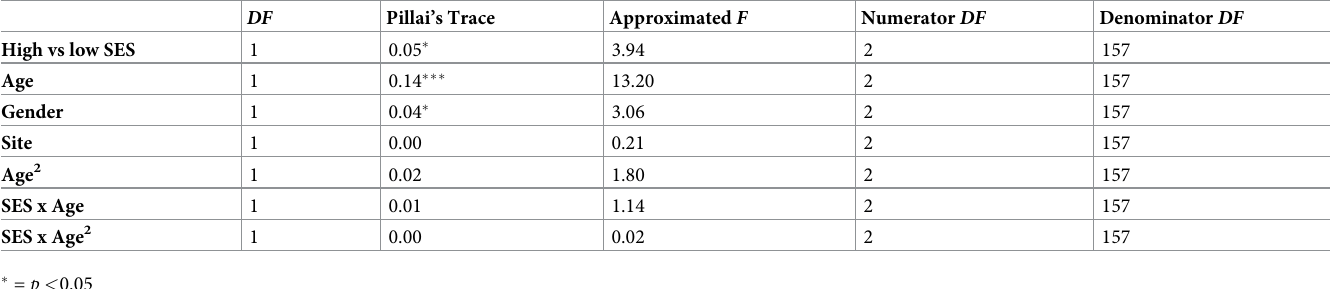
Table 7. MANCOVA of inhibition/impulsivity measures as a function of low and high SES ( N = 185).